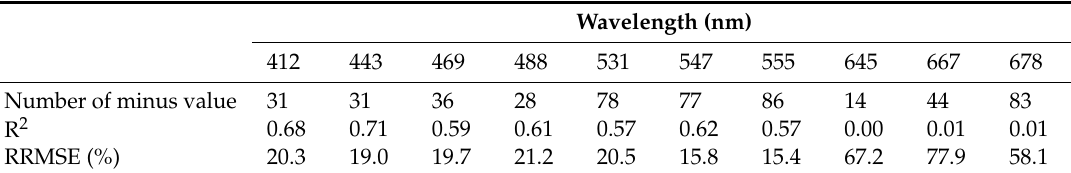
Table 3. Summary of performances of the QAA-v6 at 10 MODIS bands. R 2 and RRMSE were calculated in log10 space using full dataset ( n = 317) after omitting minus values.